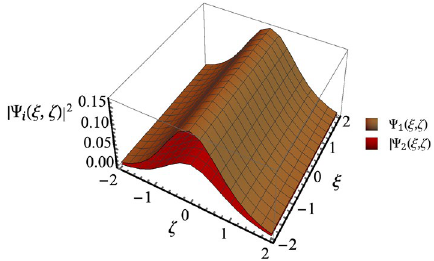
195.6 THz and ω 2 / 2 π =